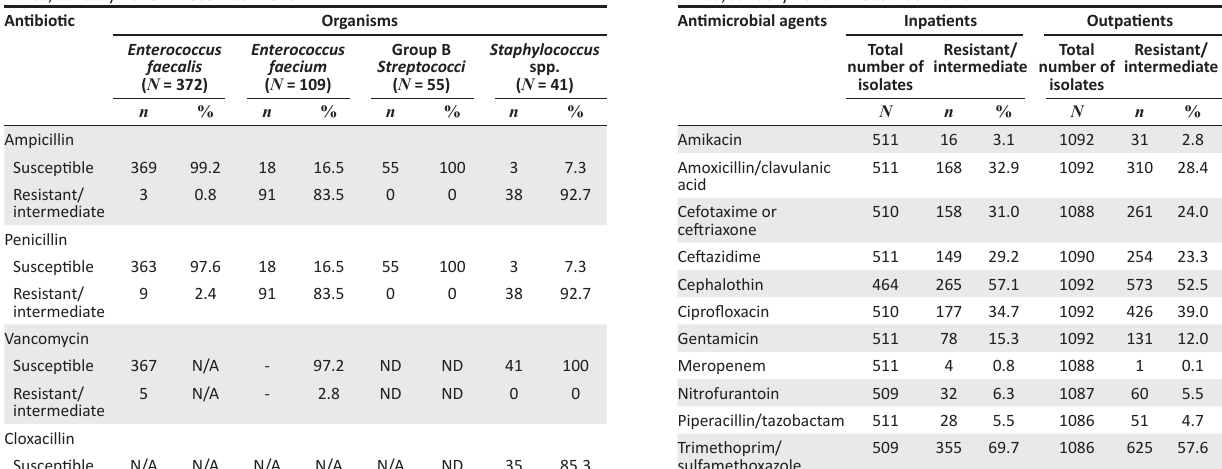
TABLE 2: Antimicrobial susceptibility patterns of E. coli isolated from inpatient and outpatient wards at the RK Khan Hospital, Durban, KwaZulu-Natal,